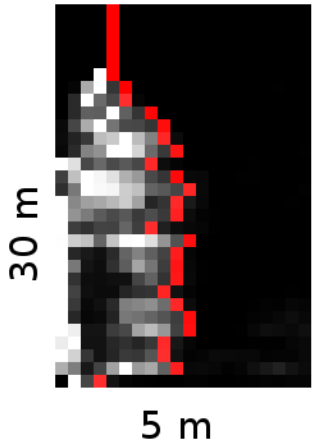
Figure 4. The outline of the tree crown in red. The TLS data points are projected onto a radially symmetric image. The x-axis is the radial distance from the tree stem, from left to right and the y-axis is the height from ground. The algorithm start the search from the top until the first canopy pixel is